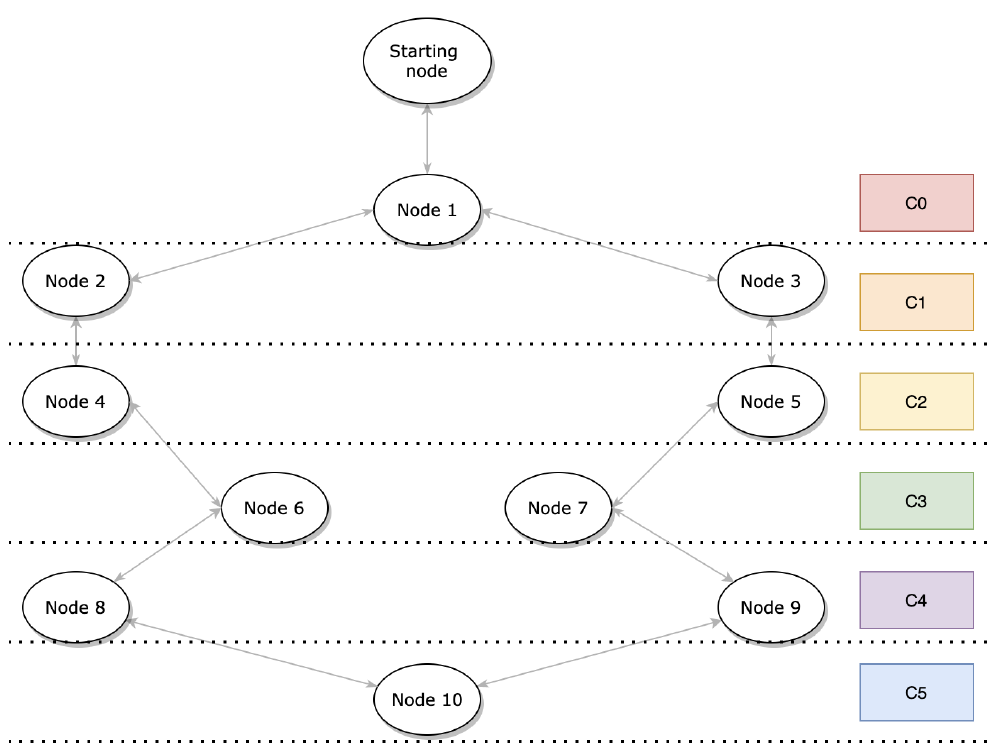
Figure 1. An example of classification of the network topology and the first network topology used in the performance eval- uation.